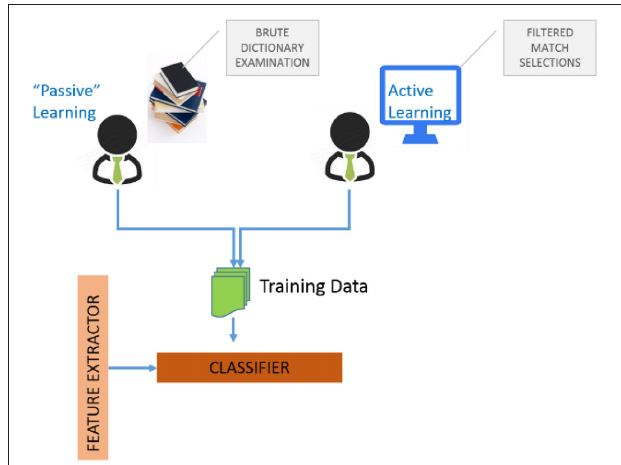
FIGURE 4 | Training data for